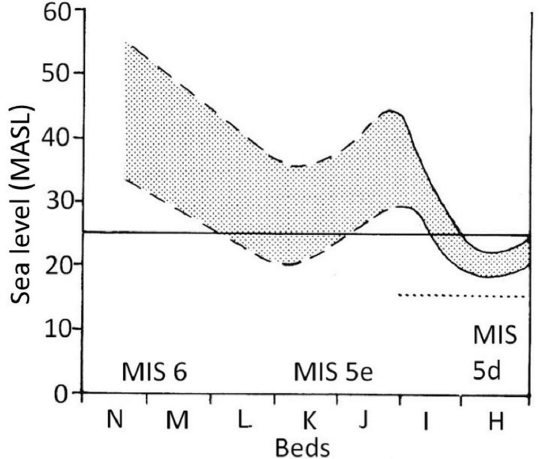
Figure 7. Relative sea-level curve for Fjøsanger during the LIG, shown as a dotted uncertainty band. The dashed part of the curve is considered most uncertain. The line at 25ma.s.l. shows the thresh- old in the Bergen Valley; when sea level was higher than this thresh- old the fjord turned into a sound that was open in both ends. The dotted line at 15ma.s.l. shows the top of the LIG marine sediments and thus the minimum altitude of the RSL during the entire LIG. Modified from Mangerud et al.